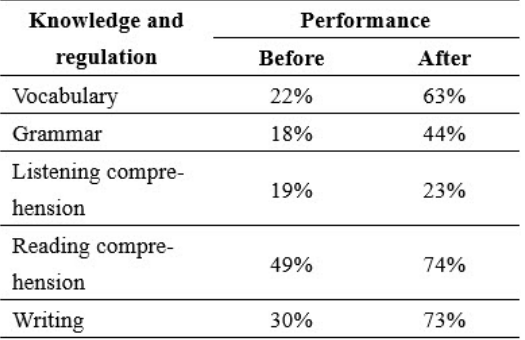
Table 4. Repeated testing with visuali-